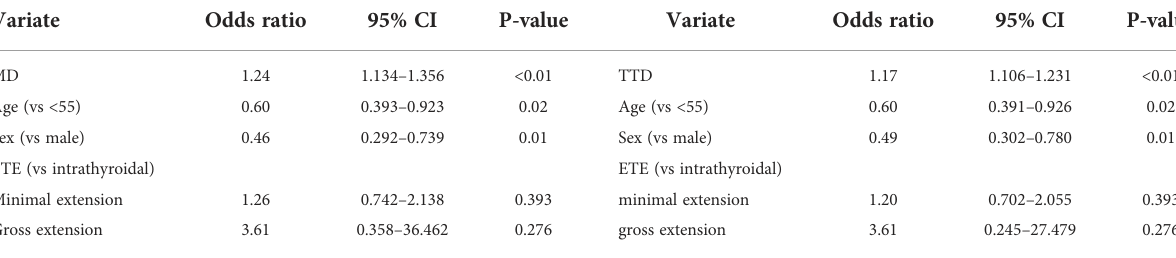
TABLE 5 Logistic regression analysis of CLNM-related risk